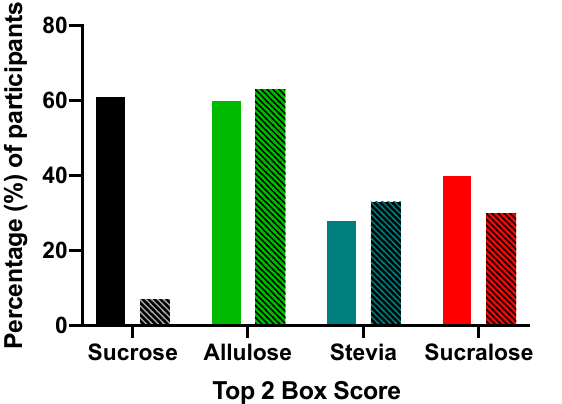
Figure 5. Top 2 box score purchase intent. The top 2 box score showed that natural sweeteners (allulose and stevia) were more likely to be purchased when information was disclosed, whereas sucrose and sucralose’s purchase intent decreased when information about those sweeteners was given to the consumers. Bars indicate percent of panelists who probably of definitely would purchase on sensory properties alone, with hatched bars after informational statement.